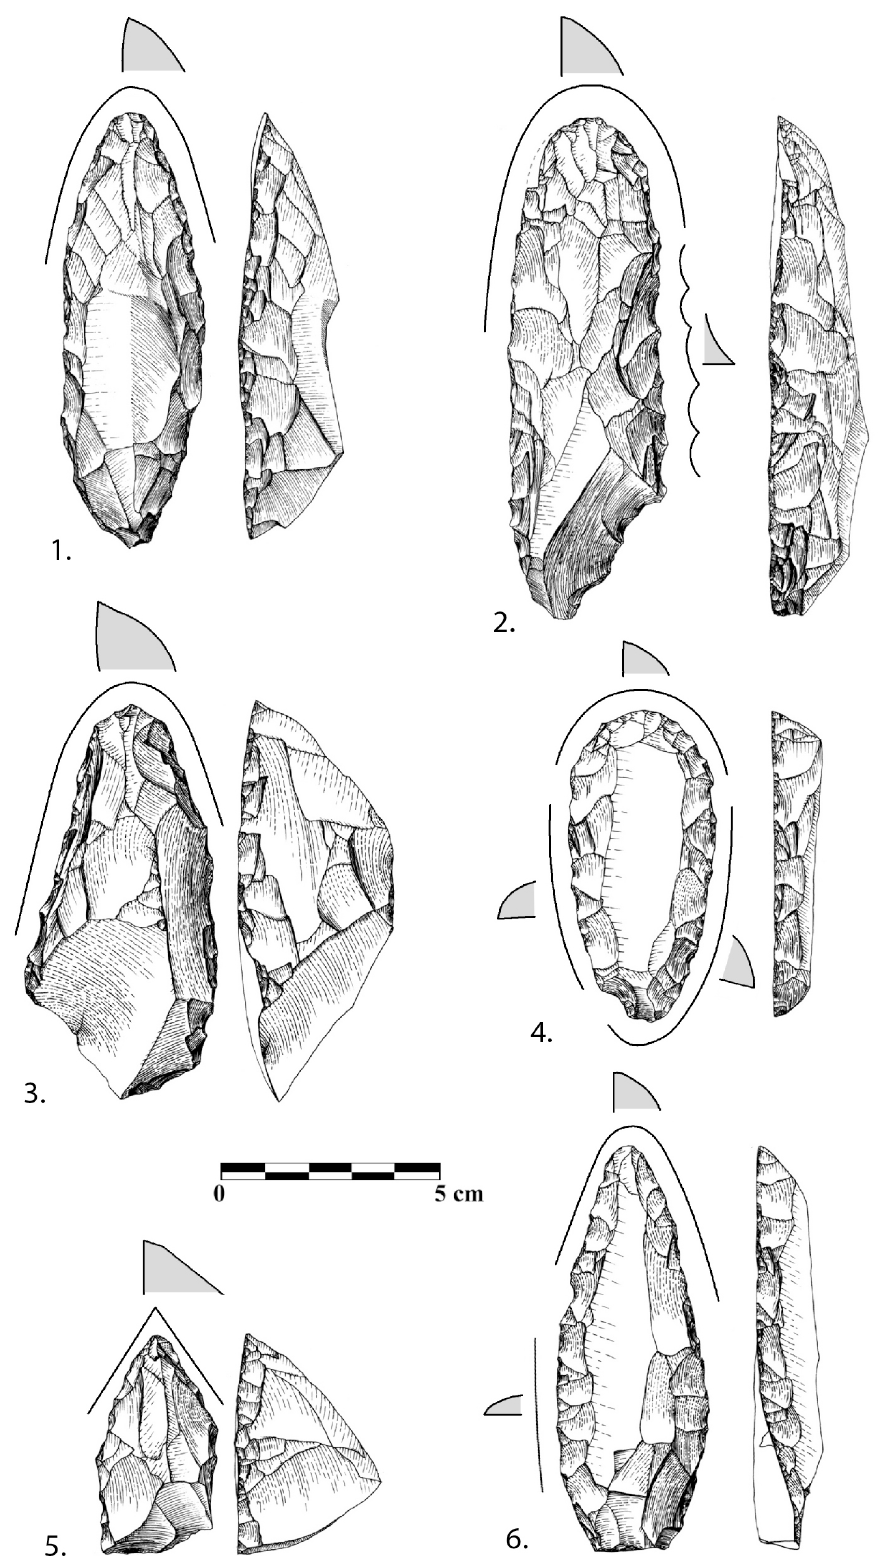
Figure 2. Exemples de pièces façonnées unifacialement du technocomplexe Itaparica provenant de GO-JA-01. La position et la délinéation de chaque partie transformative est figurée par une ligne noire, à laquelle est associée une figuration du plan de section (angles et surfaces). Figure 2. Examples of unifacially shaped artefacts of the Itaparica technocomplex, from GO-JA-01 rockshelter. The position and delineation of each transformative part are represented by a black line, associated with a section of the edge (angles and